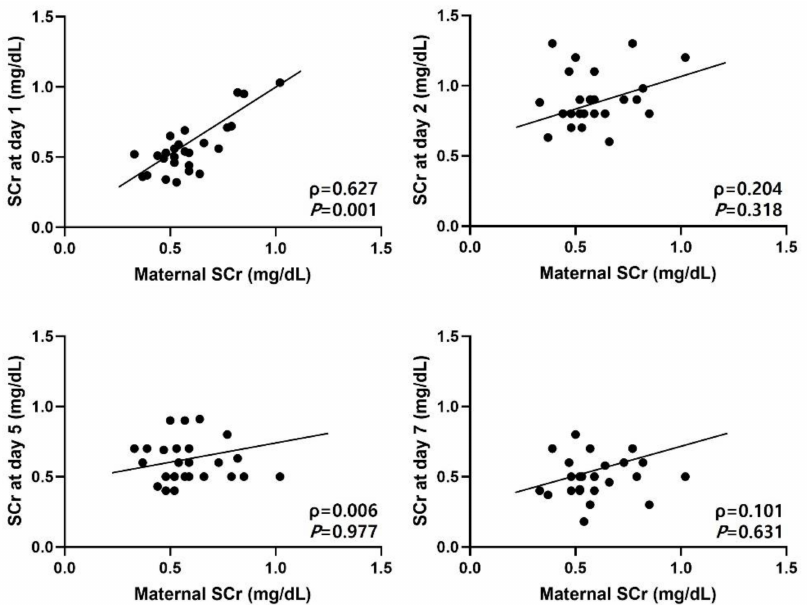
Figure 1. Correlation between maternal and neonatal serum creatinine levels. SCr, serum creatinine